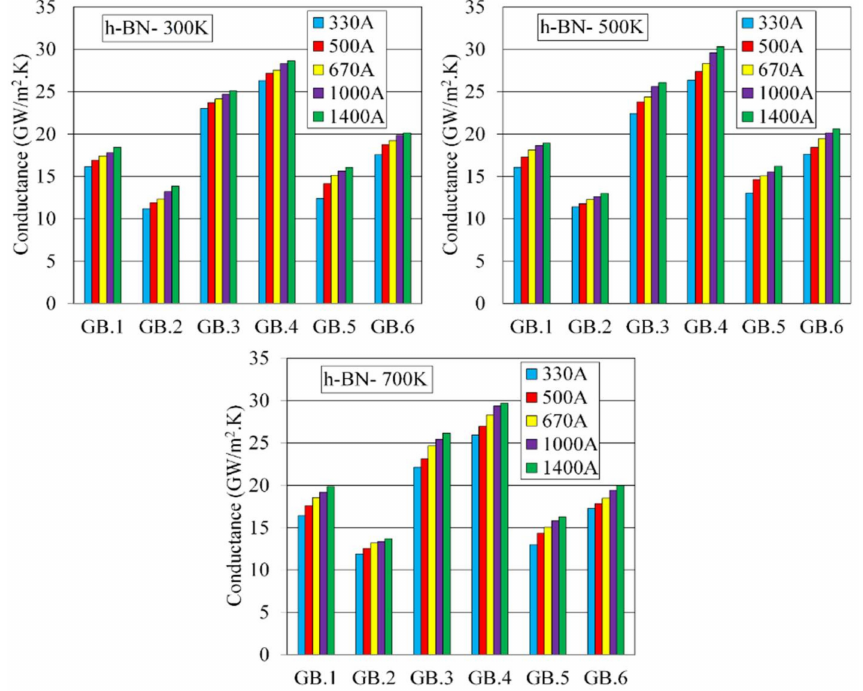
Figure 9. Predicted the term of thermal conductance of h-BN material for six grain boundaries, sheet lengths (330 A, 500 A, 670 A, 1000 A and 1400 A) and three temperatures (300 K, 500 K and 700